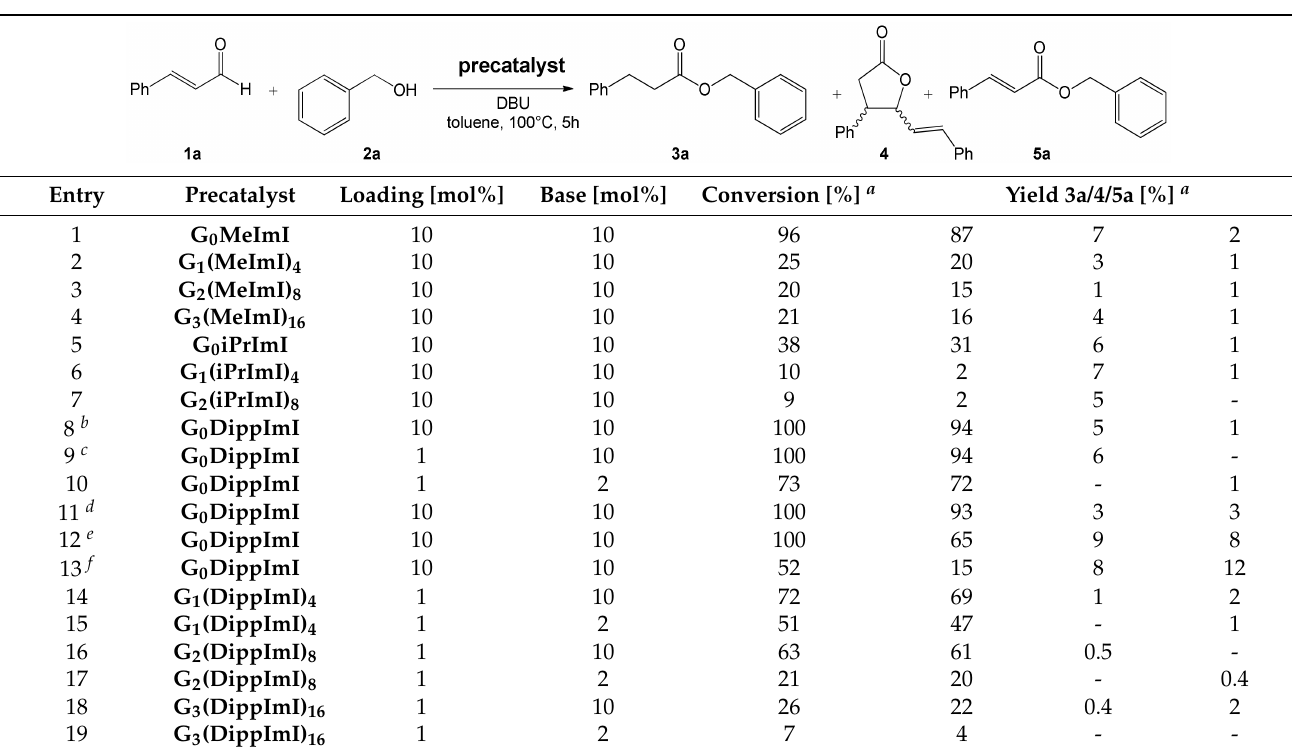
Table 1. Screening of catalysts and reaction conditions in redox esterification of cinnamaldehyde with benzyl